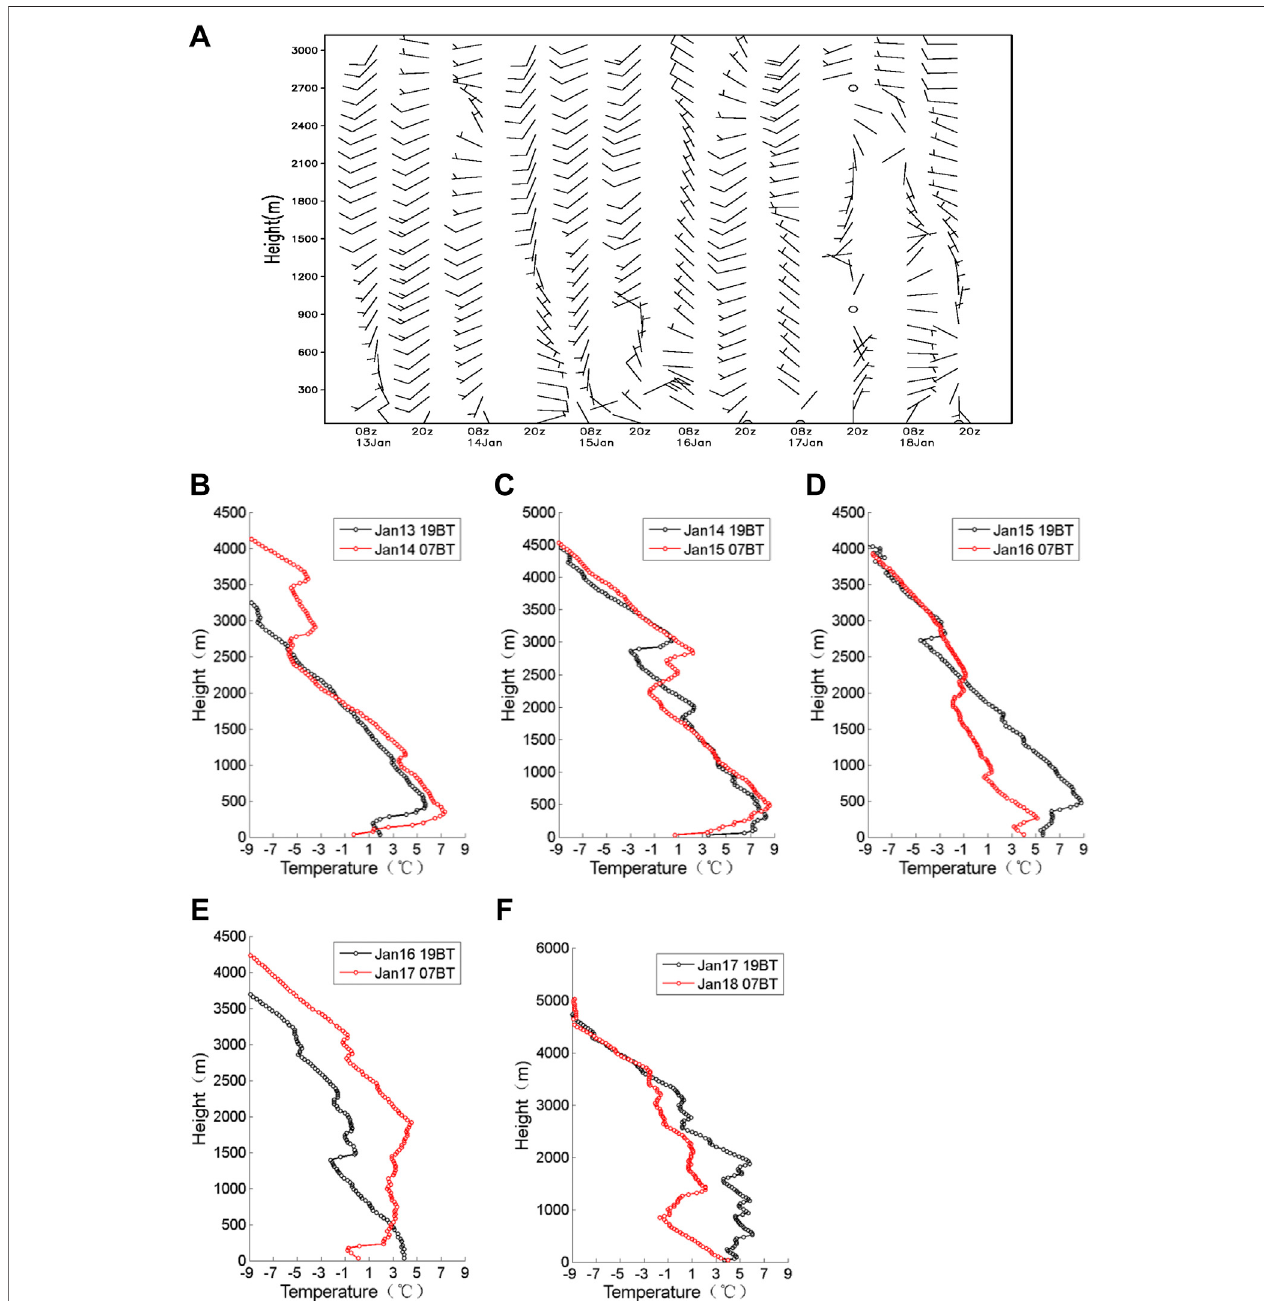
FIGURE 6 | Vertical distributions of wind vector (A) and temperature (B – F) at the Fuyang sounding station, which are shown in Figure 1 , from January 13 to January 18, 2018.